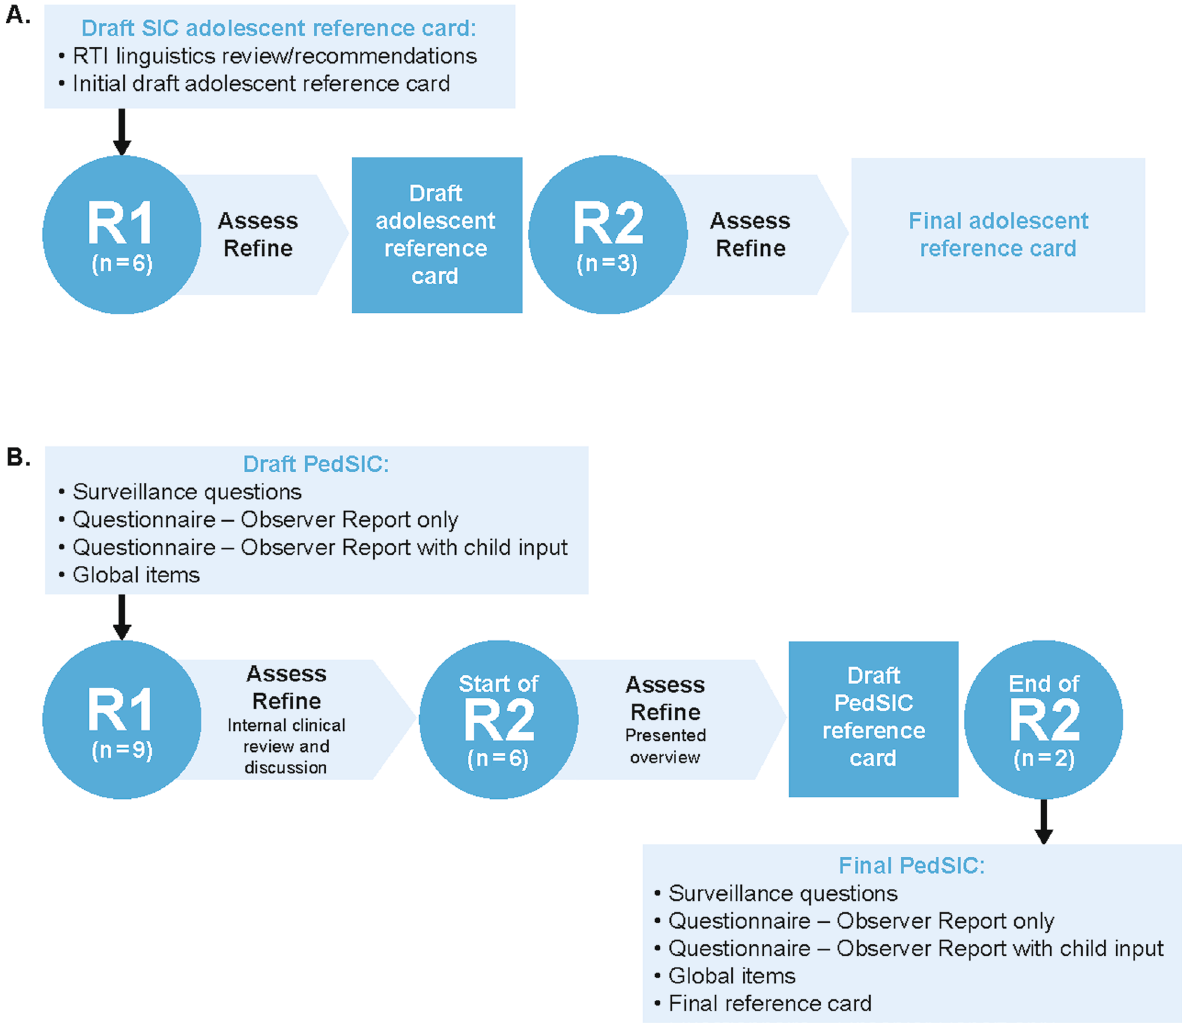
Fig. 1 Cognitive debriefing process for A adolescents and B caregivers. In panel B, surveillance questions refer to an item designed to monitor children for initial infection and medically emergent signs and symptoms of COVID‑19. PedSIC, Pediatric Symptoms of Infection with Coronavirus‑19; SIC, Symptoms of Infection with